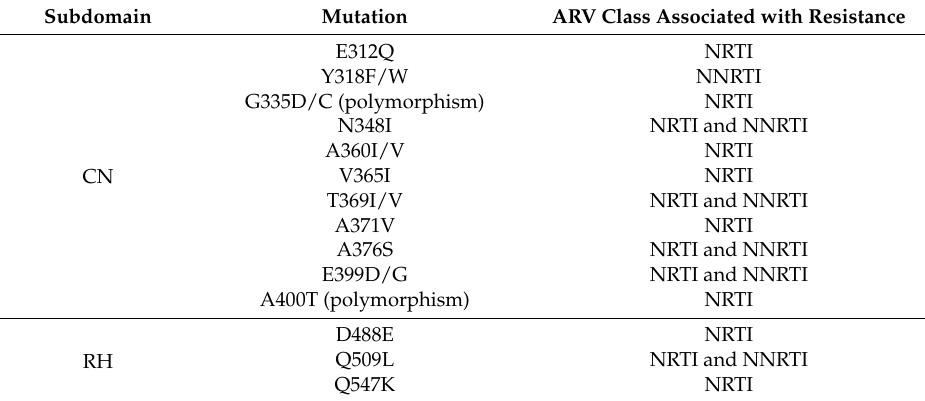
Table 1. Mutations analyzed in the C-terminal domains of reverse transcriptase covering the connection (CN) and RNase H (RH) subdomains and the respective classes of antiretrovirals associated with resistance as described in the literature